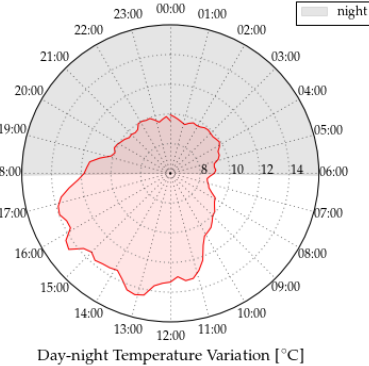
Figure 12. Day–night temperature cycle at the Cerro-Machín volcano during the rainy season (22–23 November). The gray shadow indicates the night period starting at 18:00 and ending at 06:00. The minimum temperature ( ∼ 8.5 ◦ C) is recorded at 06:30 and the maximum ( ∼ 14.5 ◦ C) at